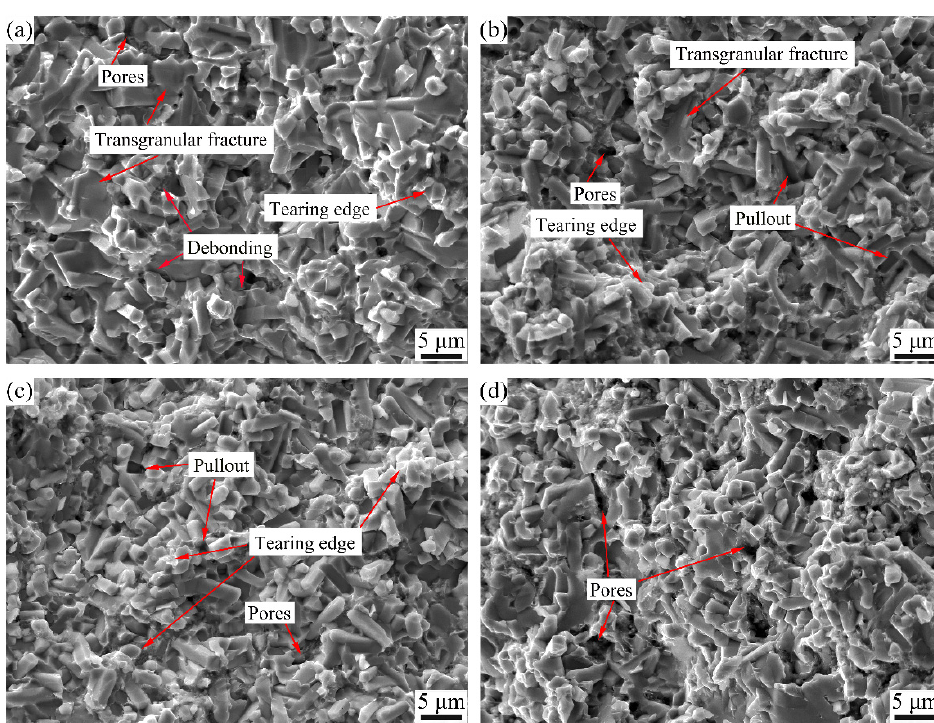
Figure 12. Fractograph of Mo 2 FeB 2 based cermets after three-point bending tests with different Mo